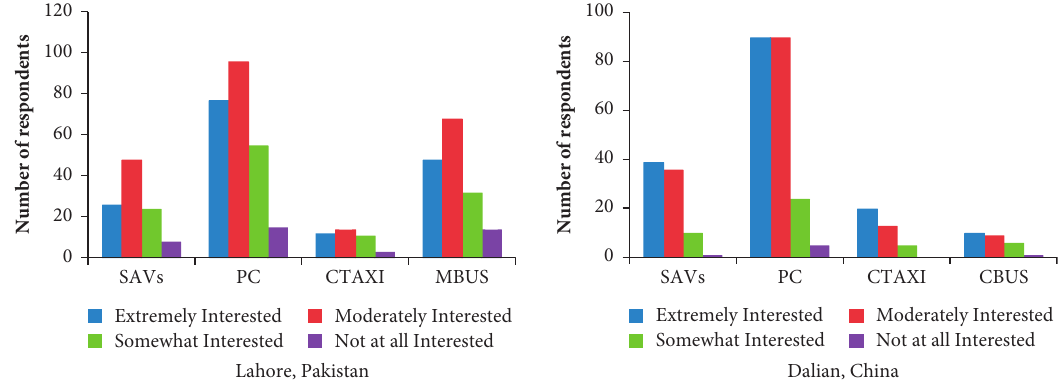
Figure 6: Preferences of automation interested individuals to shopping trips